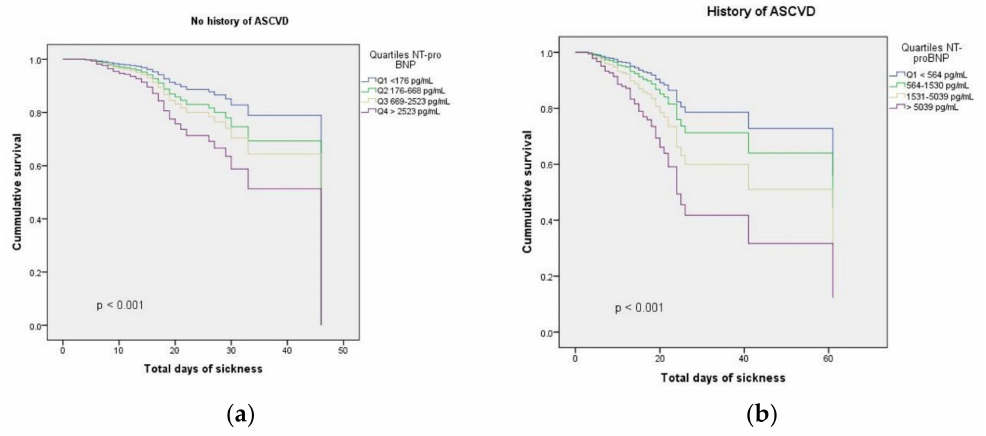
Figure 2. Kaplan–Meier survival curves regarding all-cause mortality according to the admission NT-pro BNP quartiles: ( a ) NT-pro BNP quartiles in patients without history of ASCVD; ( b ) NT-pro BNP quartiles in patients with history of